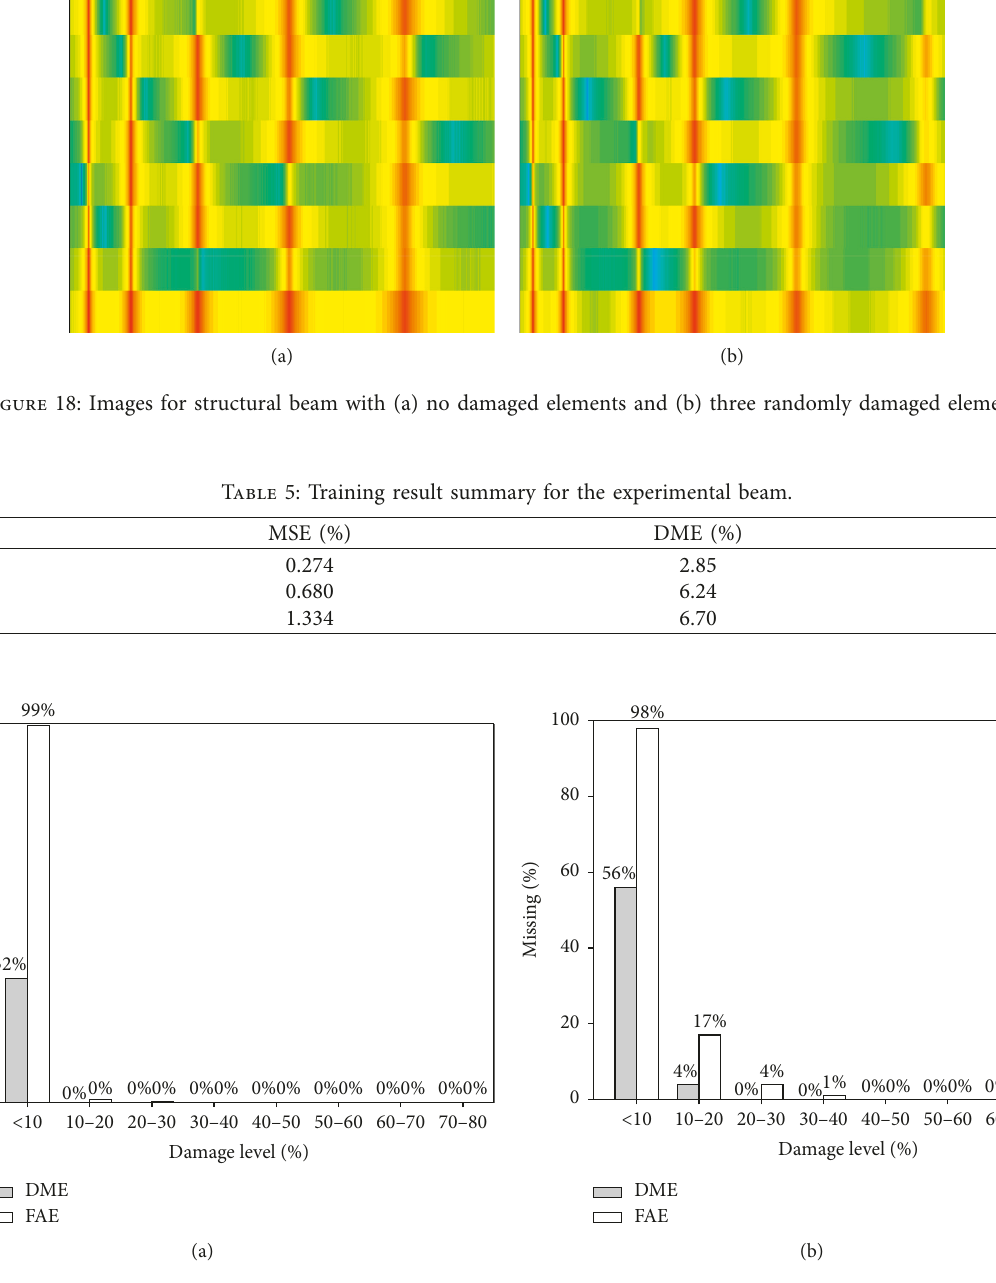
Figure 19: DME and FAE versus damage level for the structural beam using (a) model 1 and (b) model